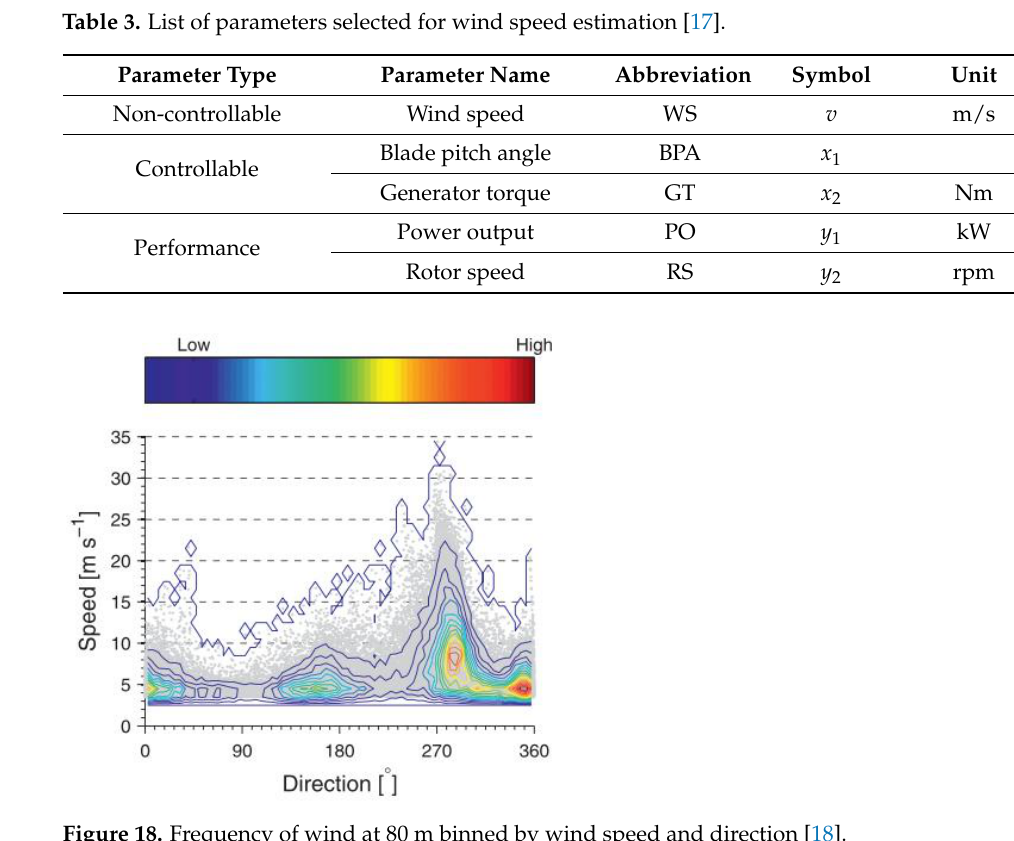
Table 3. List of parameters selected for wind speed estimation [17].